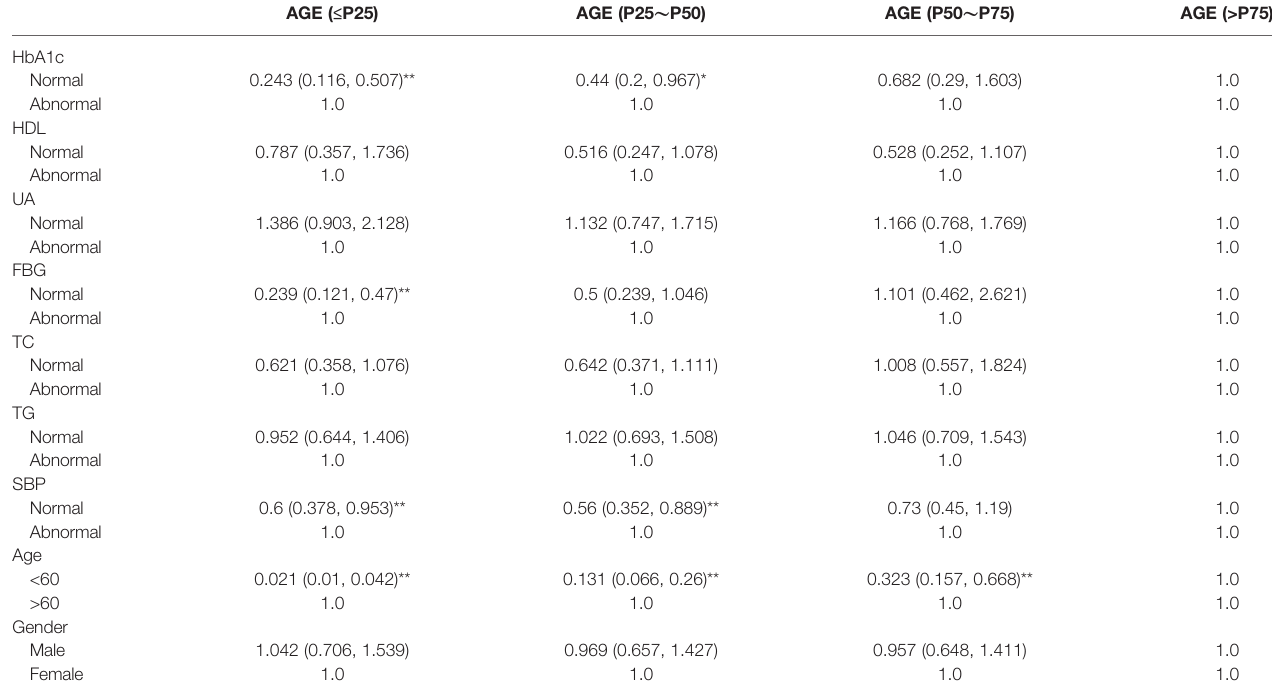
TABLE 2 | The multilevel logistic regression between risk factors and